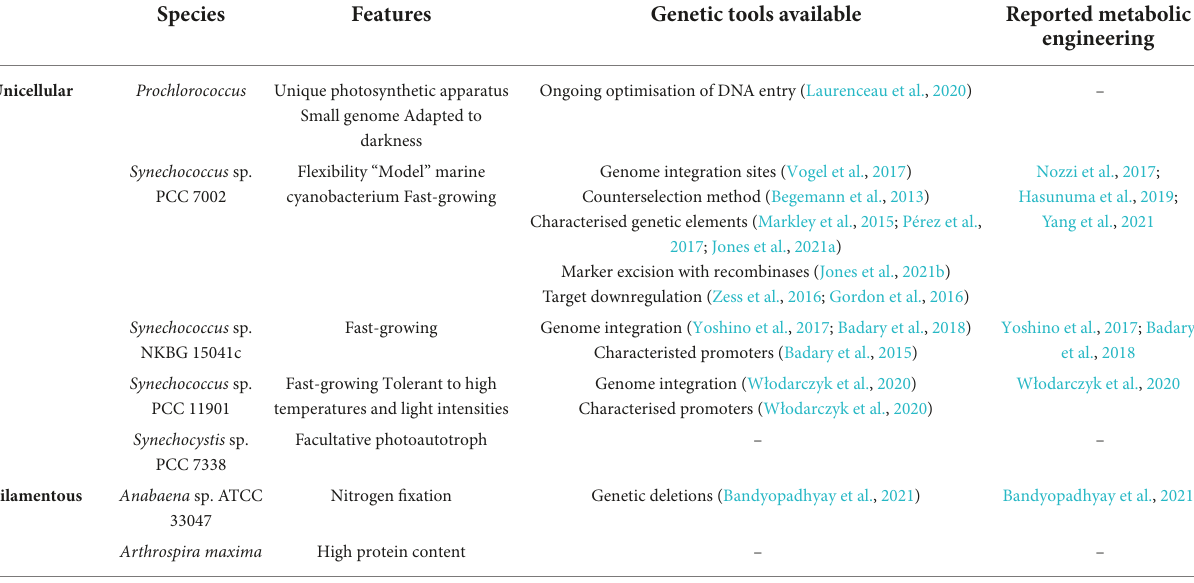
TABLE 1 Examples of genetic tools available for marine cyanobacteria and their applications for metabolic